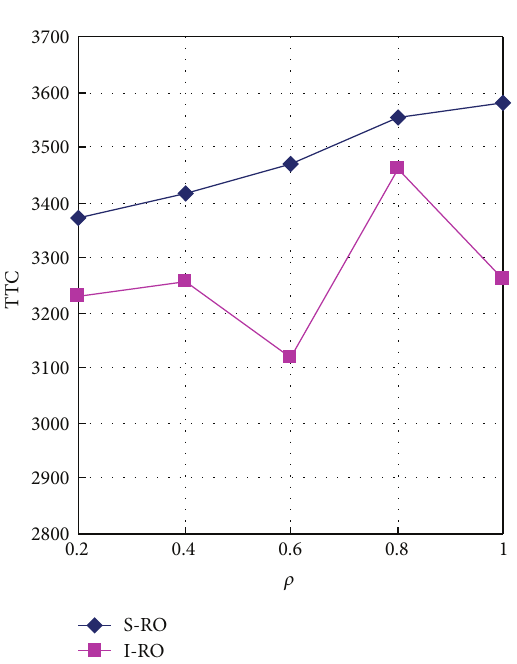
Figure 8: Variation in TTC for different 𝜌 values.